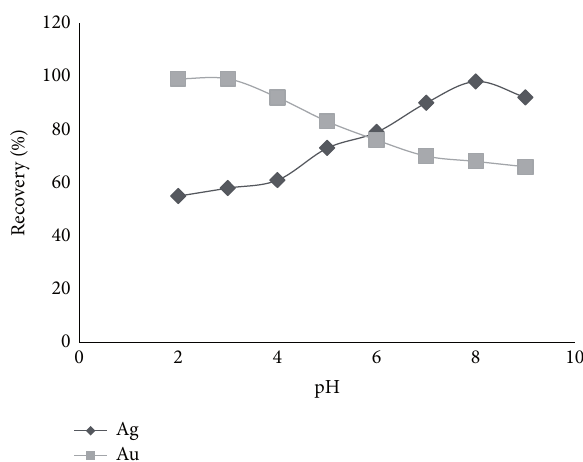
T 2: Effect of type of eluent on percent recovery of Ag(I) and Au(III) by TREN-Fe